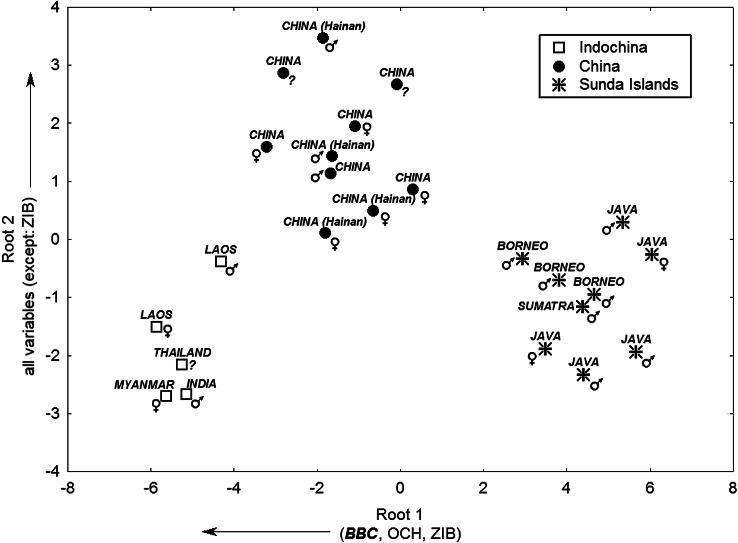
Leopard cat skull DFA morphospace across Asian regions.Bivariate plot of 24 P. bengalensis according to individual discriminant function scores, considering three major geographical regions. Arrows indicate the direction of the contribution of variable loadings to the respective canonical roots. Subregions are identified for each individual. Sexes are identified as males = ♂, females = ♀, and indeterminate = ?.